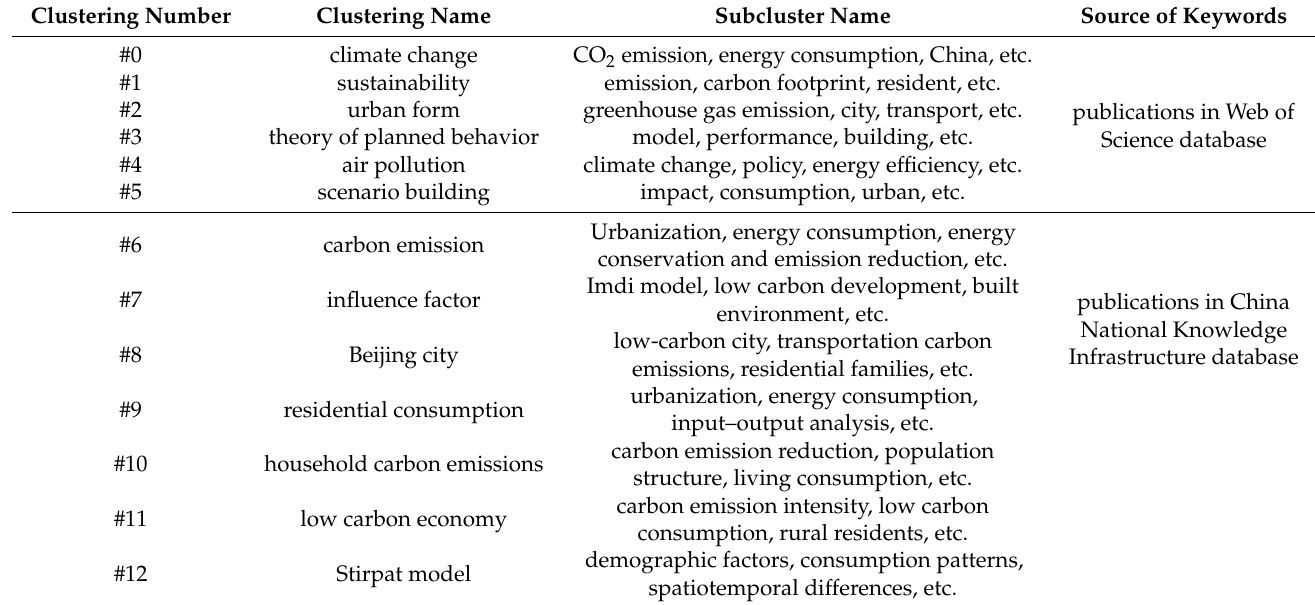
Table 2. Cluster analysis of